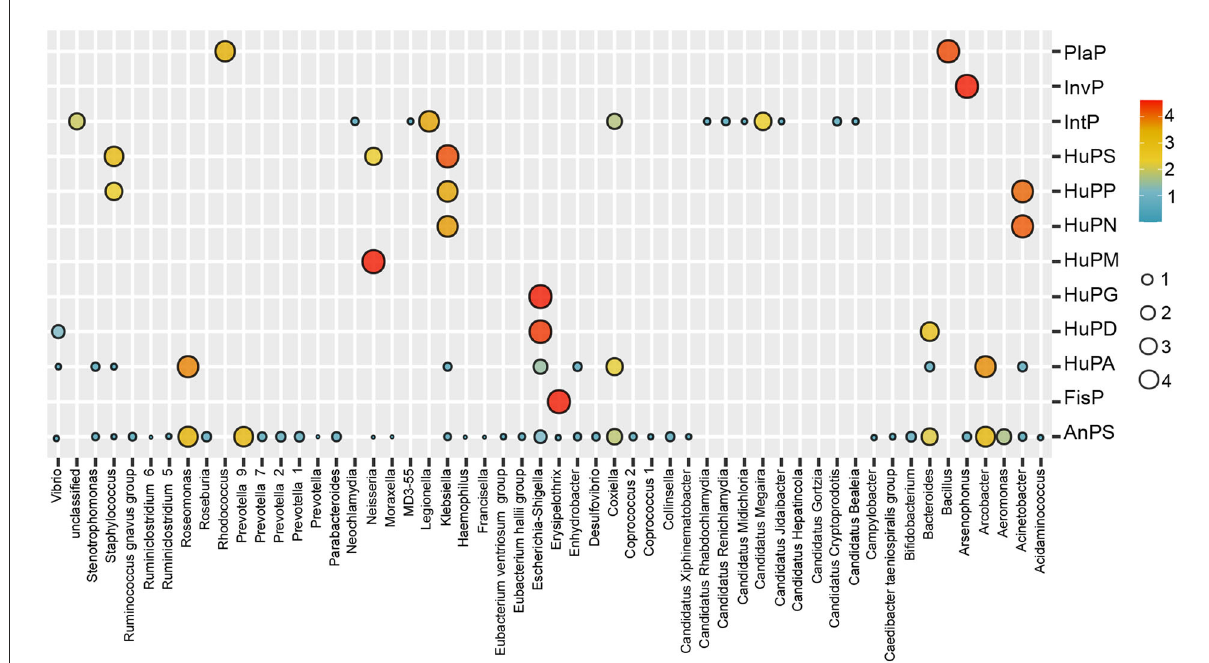
FIGURE3 Bubble map showing the distribution of potential pathogenic groups in each pathogenic genus. AnPS, animal parasites or symbionts; IntP, intracellular parasites; InvP, invertebrate parasites; HuPA, human pathogens all; HuPD, human pathogens diarrhea; HuPG, human pathogens gastroenteritis; HuPM, human pathogens meningitis; HuPN, human pathogens nosocomia; HuPP, human pathogens pneumonia; HuPS, human pathogens septicemia; PlaP, plant pathogen; FisP, fish parasites.